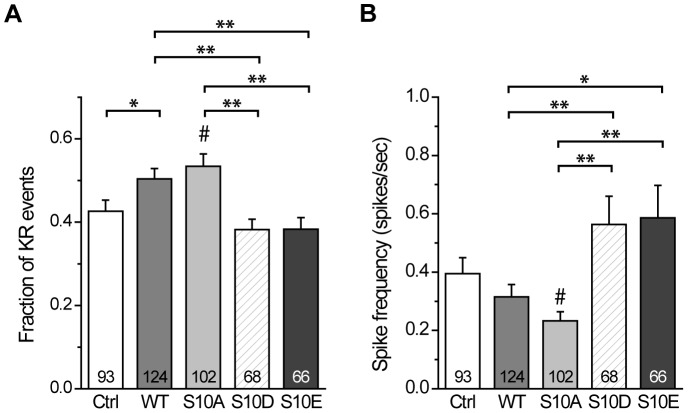
Fraction of KR events and spike frequency in cells overexpressing CSP and its phosphomutants.
A, Fraction of KR events for the different groups. This fraction was calculated using the cellular mean method as the ratio of event numbers (i.e, number of 2–3.5 pA events divided by number of all events). Total 513–804 KR events from those cells. B, Spike frequencies for each group calculated using the cellular mean method from the start of KCl treatment to the end of recording (25 sec). Signals with peak amplitudes ≥3.5 pA were considered as spikes. Numbers in bars indicate the number of cells analyzed. Total 593–977 spikes from those cells.